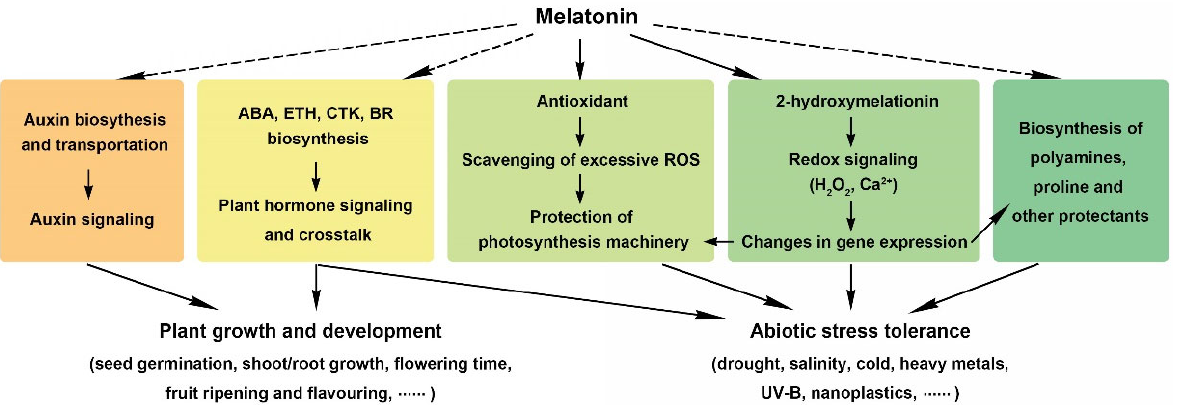
Figure 3. The function and mechanism of melatonin in the regulation of plant growth, development, and abiotic stress tolerance. To regulate seed germination, shoot/root growth, flowering time, and fruit ripening and flavoring, melatonin mainly modulates plant hormone crosstalk. To regulate drought, salinity, cold, heavy metals, UV-B, and nanoplastics tolerance, melatonin serves as an antioxidant in plant cells and induces the biosynthesis of polyamines, proline, and other protectants. The dotted lines indicate that the mechanism is